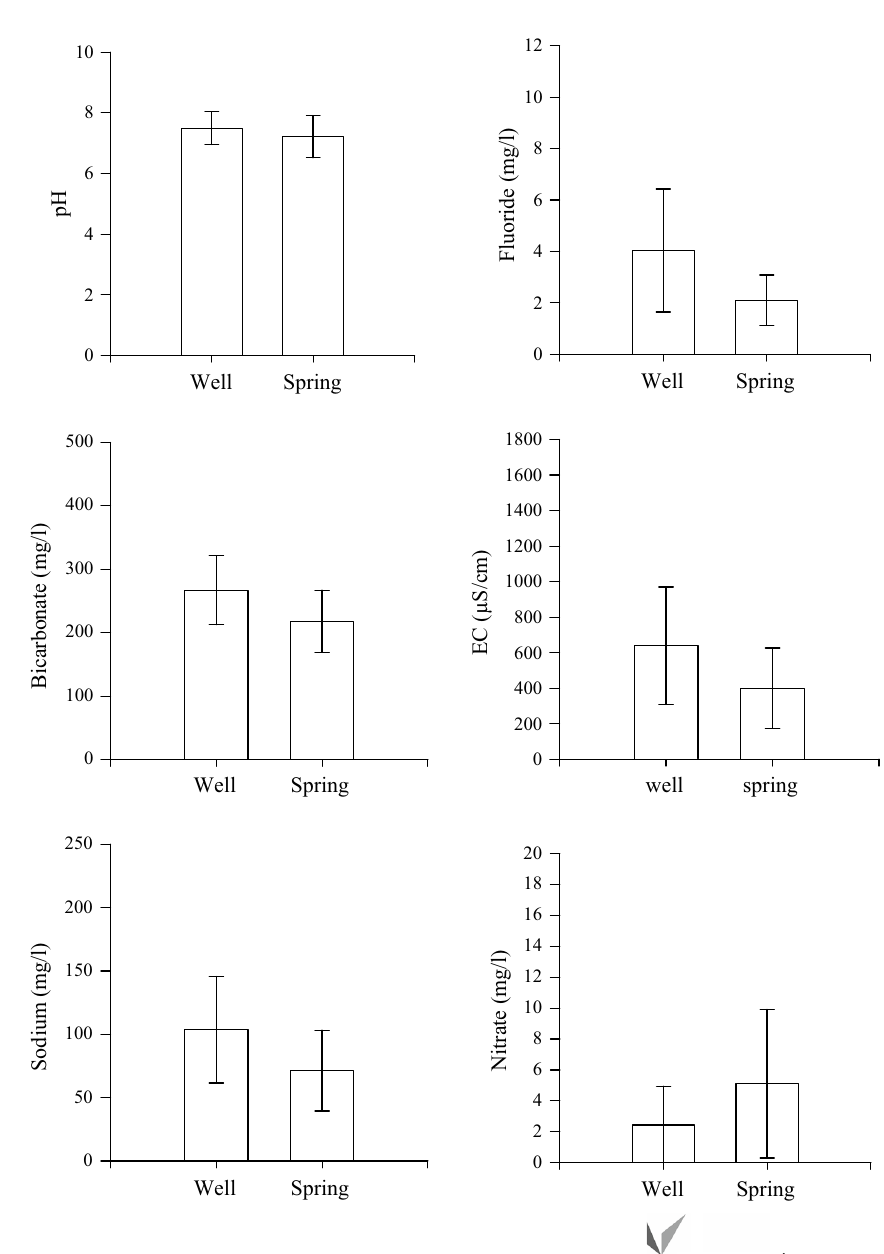
Fig. 9 Comparison of means of selected major ions in spring and well